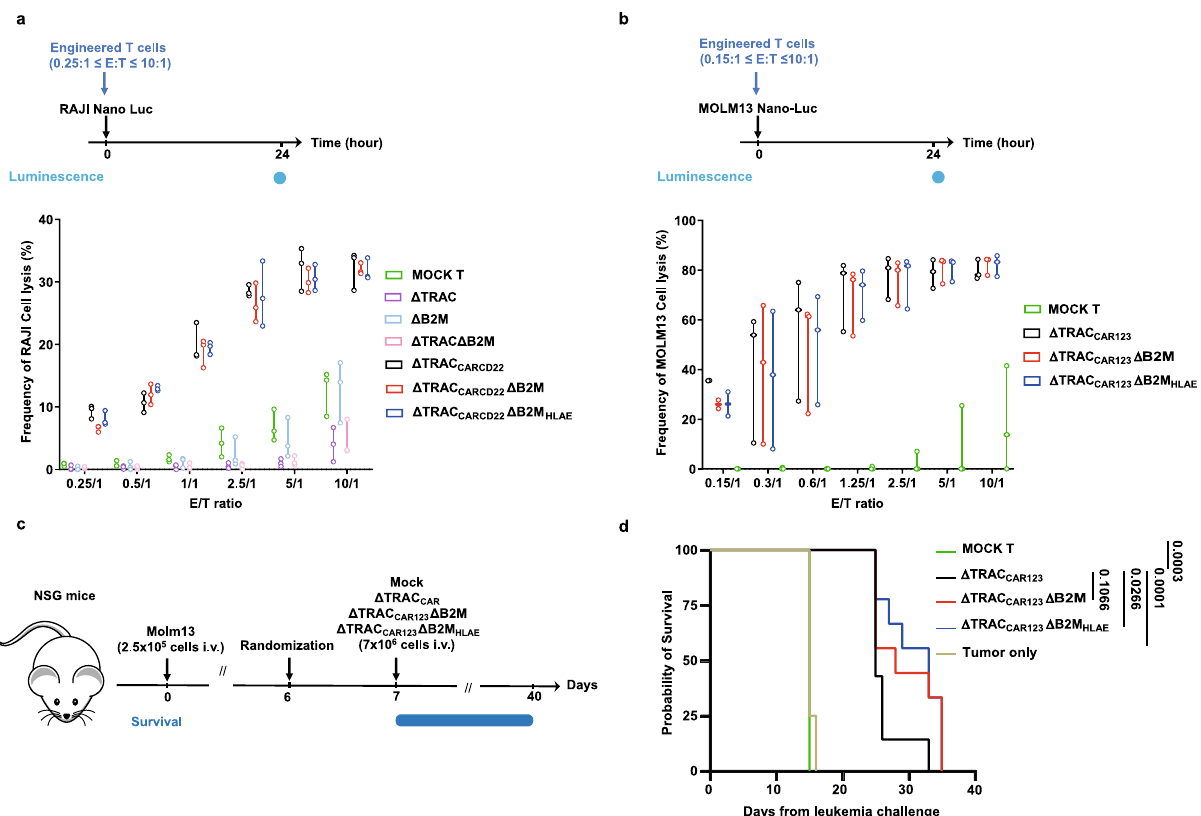
Fig. 2 The disruptive targeted insertion of HLA-E at the B2M locus does not affect the antitumor activity of Δ TRAC CAR Δ B2M HLAE . a , b Antitumor activity of engineered T cells in vitro. T cells edited as indicated and expressing a CAR speci fi c for either CD22 ( a ) or CD123 ( b ) were co-cultivated in vitro, with nano-luciferase-expressing RAJI or MOLM13 leukemia cell lines, respectively, using variable effector to target (E/T) ratios. The nano-luciferase signal obtained after co-culture was normalized to the one obtained for tumor cells fully depleted by Zwittergent ® to determine the frequency of tumor cells lysis. On each box plot, the central mark indicates the median, the bottom and top edges of the box indicate the interquartile range (IQR), and the whiskers represent the maximum and minimum data point. Each point represents one experiment performed with a given T-cell donor ( n = 3 biological replicate for CAR T-cell speci fi c for CD22 and CD123, n = 3 and n = 1 technical replicates for CAR T-cell-speci fi c CD22 and CD123, respectively). p -values are documented in the source fi le for clarity. c Schematic showing the experimental design to investigate the antitumor activity of Δ TRAC CAR123 Δ B2M HLAE in the xenograft mouse model. Immunode fi cient NSG mice were adoptively transferred with MOLM13-Luc-GFP leukemia cells (2.5 × 10 5 cells/mouse in 100 μ L of PBS via i.v.). On day 7, leukemia-bearing mice were adoptively transferred (i.v.) to randomized mice with mock-transduced T cells ( n = 7), Δ TRAC n = 7), Δ TRAC Δ B2M T cells ( n = 9), Δ TRAC Δ B2M n = 9) or no T cells ( n = 8) (7 × 10 6 viable CAR + cells/ CAR123 T cells ( CAR123 CAR123 HLAE T cells ( mouse in 100 μ L of PBS via i.v. injection). Mice were monitored and followed for overall survival. d Kaplan – Meier plot obtained for different mouse cohorts. Log-rank (Mantel – Cox) tests were used for statistical analysis. P values are indicated on the fi gures. Source data are provided as a Source Data fi